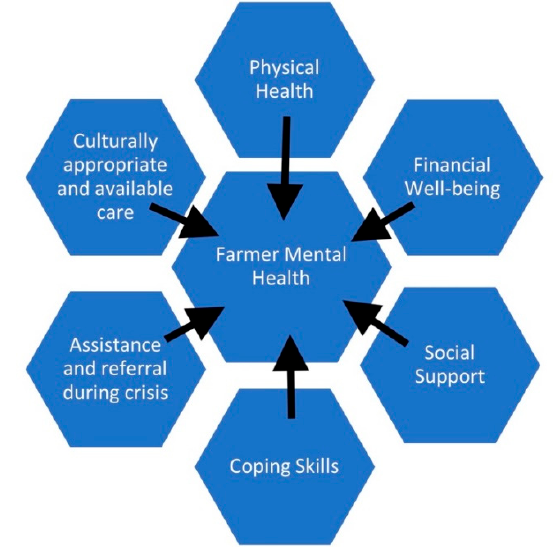
Figure 1. Drivers of farmer mental